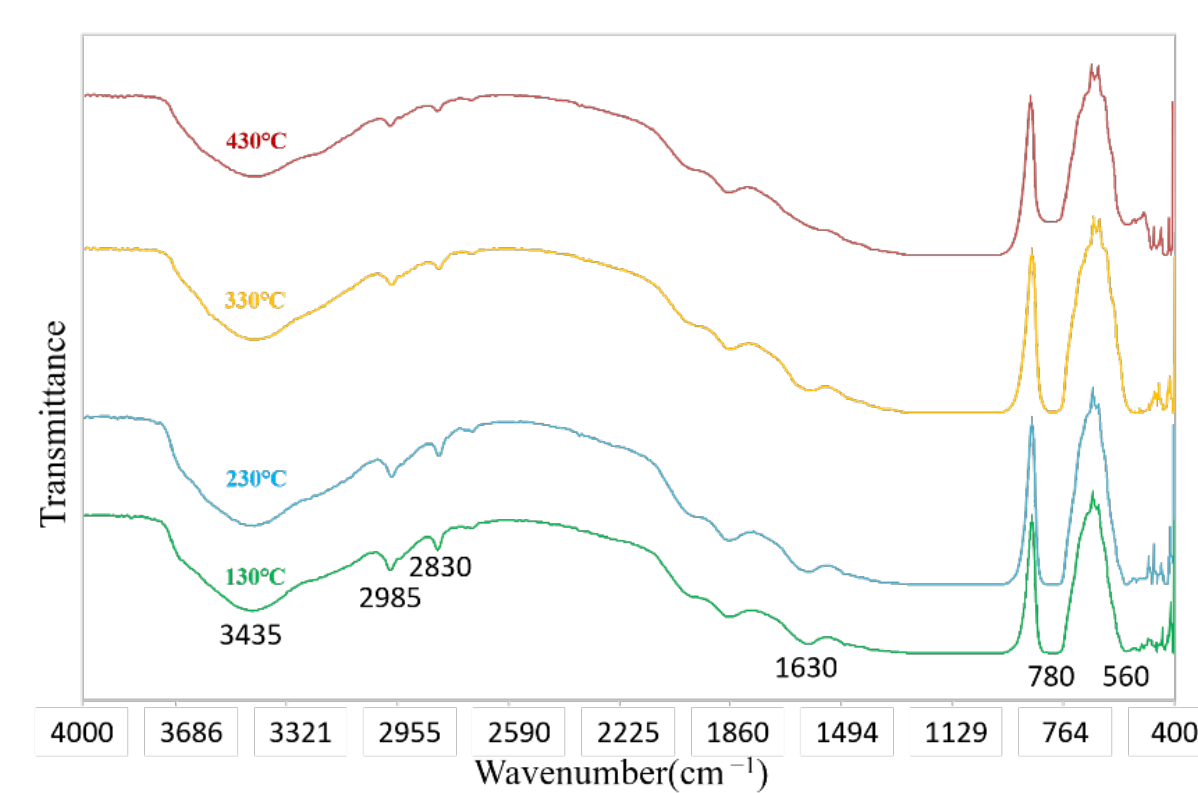
Figure 18. Infrared spectra of coatings after heat treatment at different temperatures.